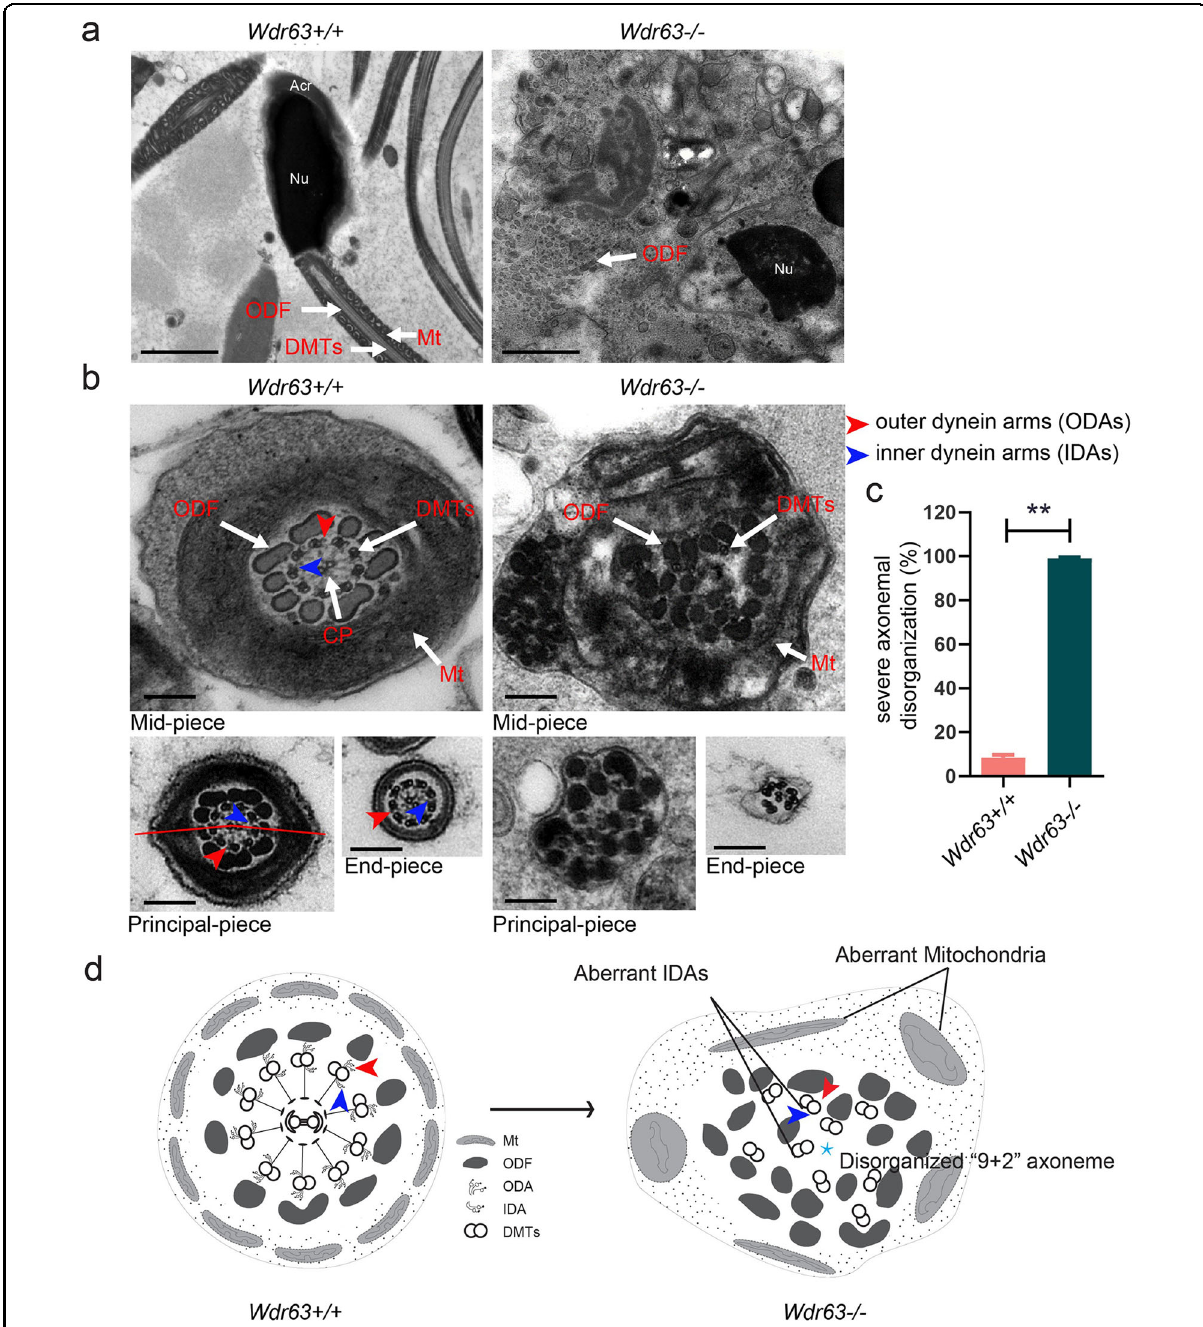
Fig. 4 Ultrastructure analyses for Wdr63 -KO male mice show a severely disorganized axoneme disorganization arrangement. a Longitudinal sections of spermatozoon mid-piece in adult male mice. Wdr63 + / + male mice sperm had a symmetrical mid-piece with smooth axoneme surrounding with a regularly arranged mitochondrial sheath. In contrast, Wdr63 − / − male mice showed a seriously disorganized ODF and de fi cient of axoneme and mitochondrial sheath. Scale bars, 2 μ m. b , c Cross-sections of spermatozoon fl agella the mid-piece, principal piece, and end-piece in adult male mice. Wdr63 + / + male mice show the typical “ 9 + 2 ” microtubule structure, whereas nearly all spermatozoon of Wdr63 − / − male mice show severe disorganized “ 9 + 2 ” axoneme. Scale bars, 200 nm. d Schematic of spermatozoon fl agella cross-sections ultrastructure in Wdr63 + / + and Wdr63 − / − male mice. Abbreviations: Nu, nucleus; Acr, acrosome; DMT, peripheral microtubule doublets; ODF, outer dense fi bers; CP, central pair of microtubules; Mt, mitochondrial sheath; ODA, outer dynein arms (red arrows); IDA, inner dynein arms (blue arrows). For c , n = 3 and the bars represent means ± SEM. The statistical analysis was carried out using One-way ANOVA test, ** denotes P <